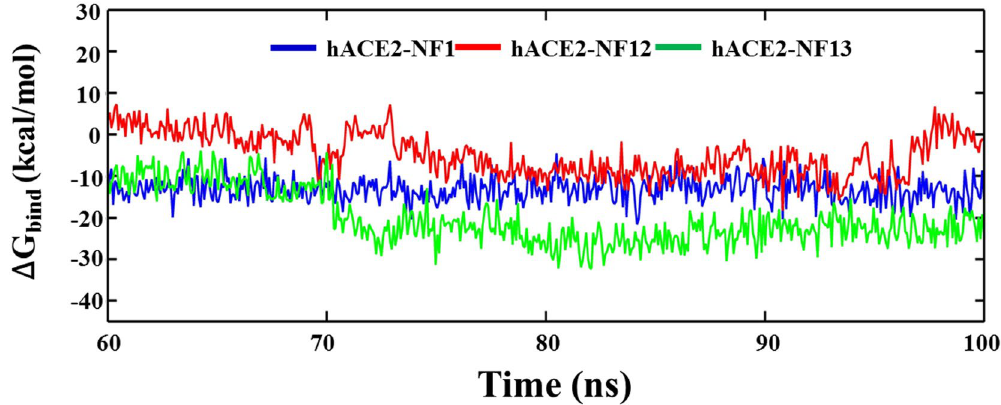
Figure 6. Binding free energy (ΔG bind ) estimation of ligands, NF1, NF12, and NF13 with ACE2, using MM-PBSA.